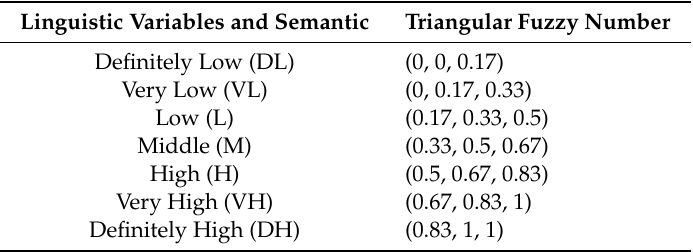
Table 2. Linguistic scales and their corresponding triangular fuzzy numbers.